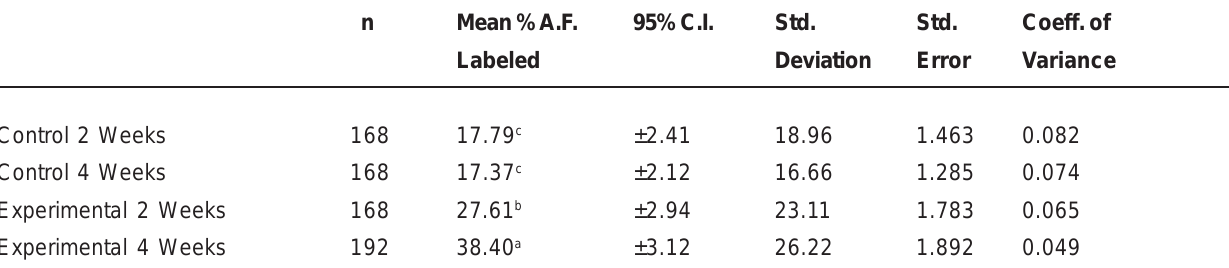
a,b, and c- statistical group CI overlap at 95% level of